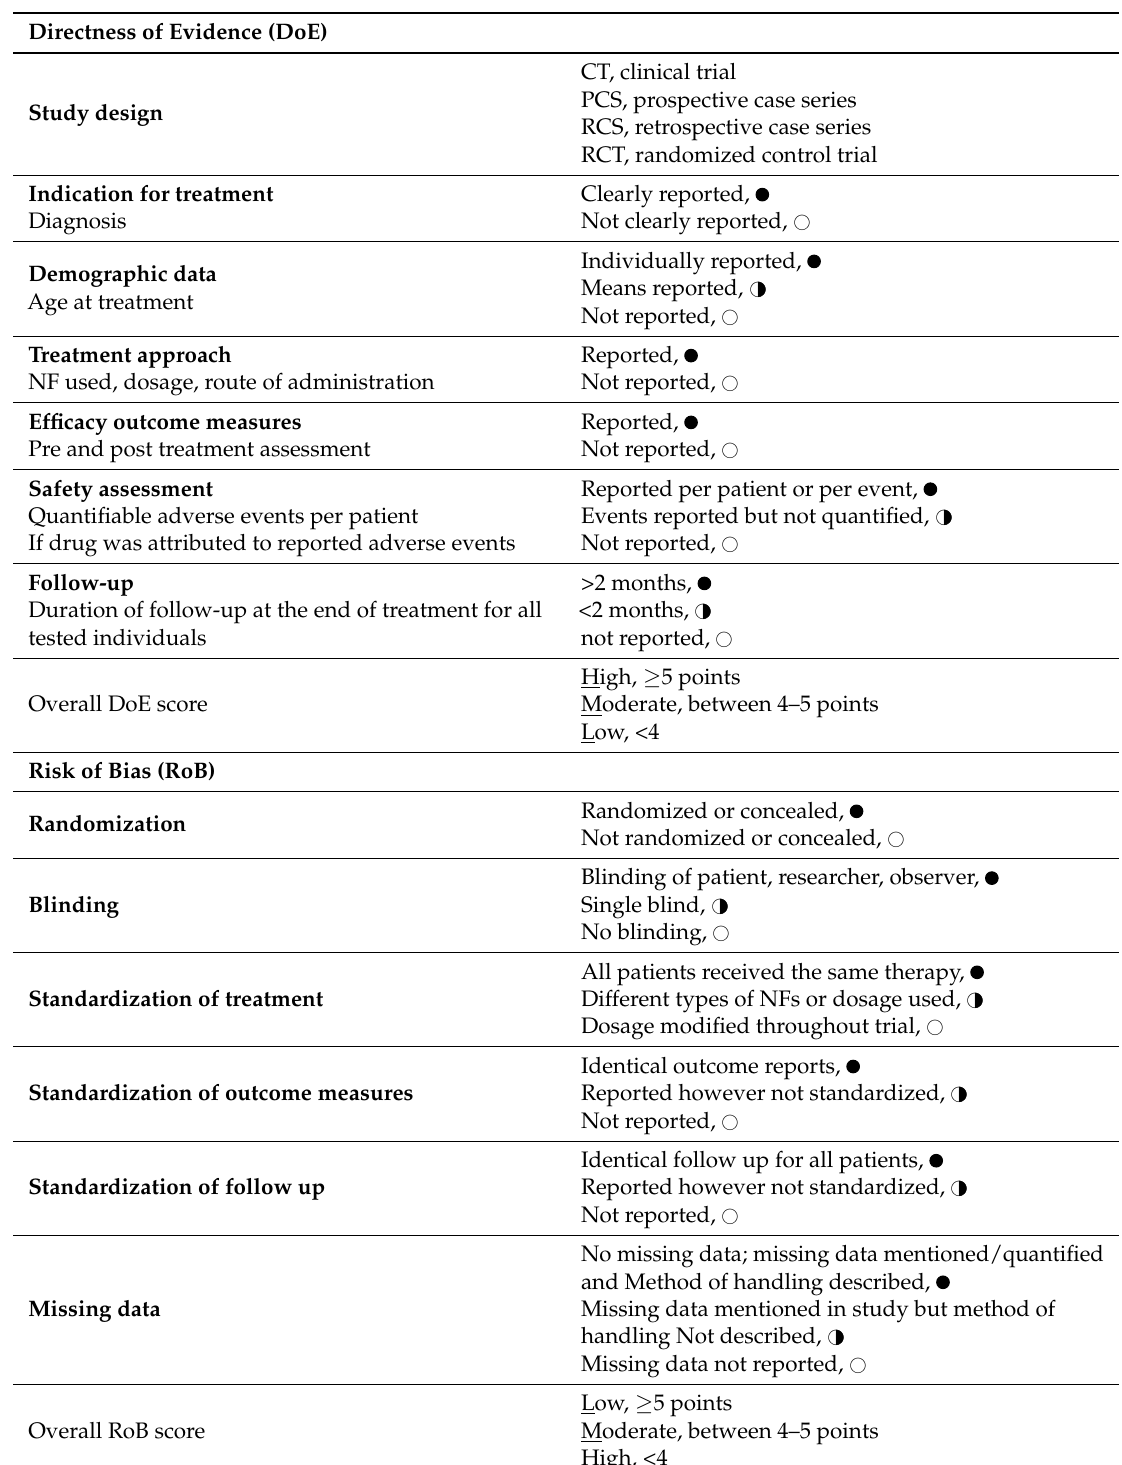
Table 2. Legend critical appraisal. Assessment per item for critical appraisal of selected